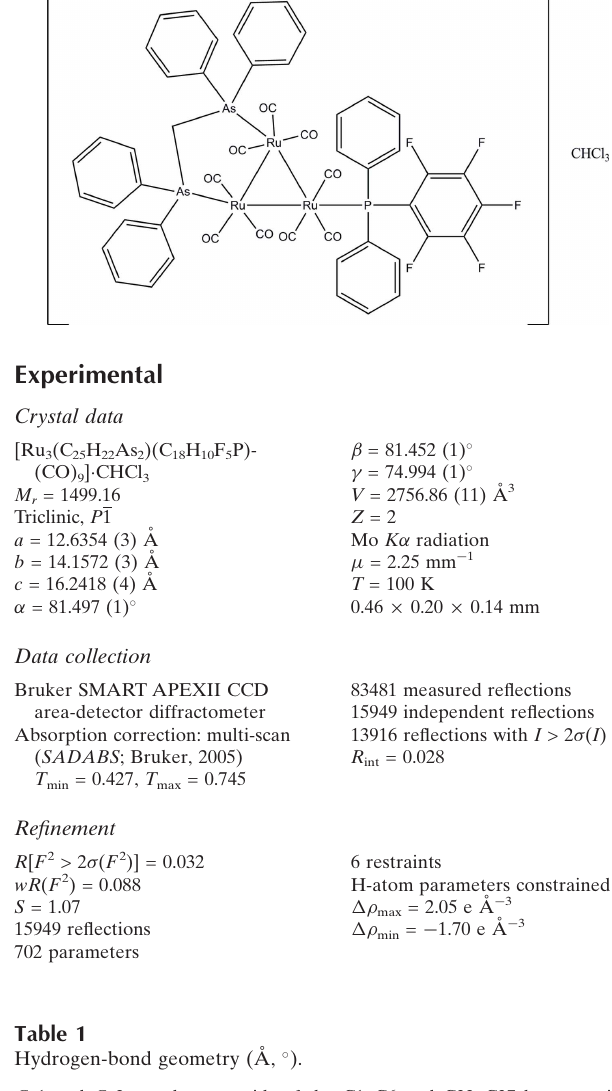
Hydrogen-bond geometry (A ˚ , (cid:3)